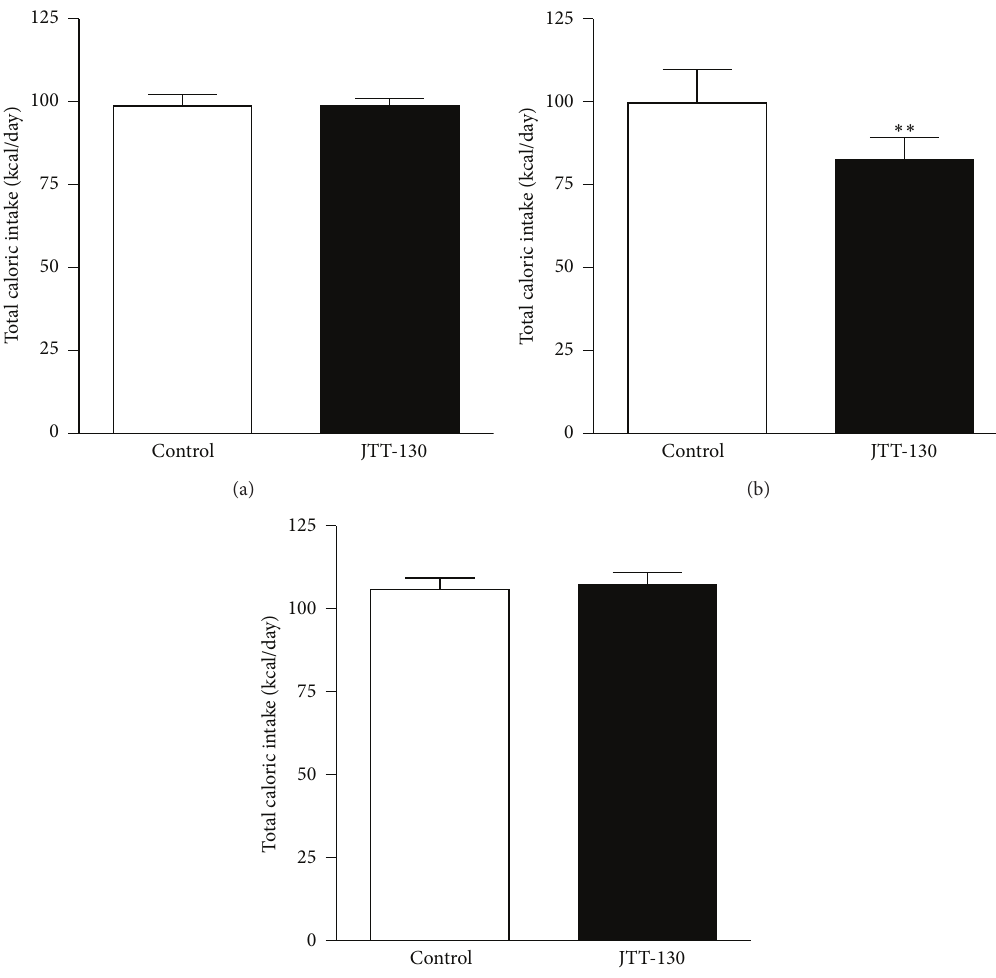
Figure 4: Effects of JTT-130 on total caloric intake. Total caloric intake was calculated from average daily intake of LF and HF diets during baseline (a), the treatment period (b), and recovery period (c). Data are presented as means ± S.E. from ten animals. ∗∗ 𝑃 < 0.01 versus control